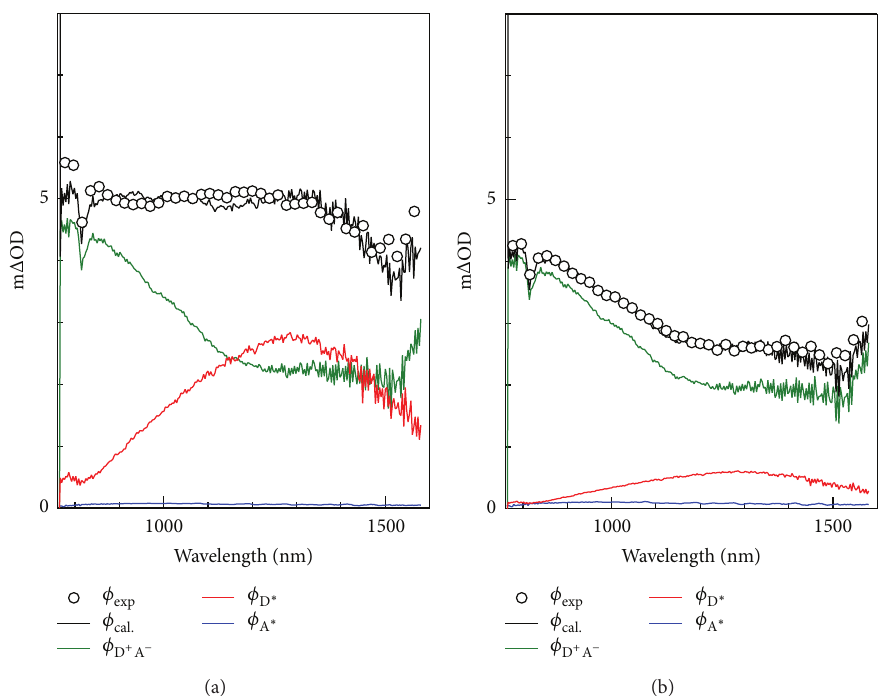
Figure 10: Δ OD spectra of rr-P3HT/PCBM blend film at (a) 0.3 ps and (b) 4.1ps at 300 K. Solid curves are results of the decomposition into 𝜙 𝜙 𝜙 D + A − , A ∗ , and D ∗ .